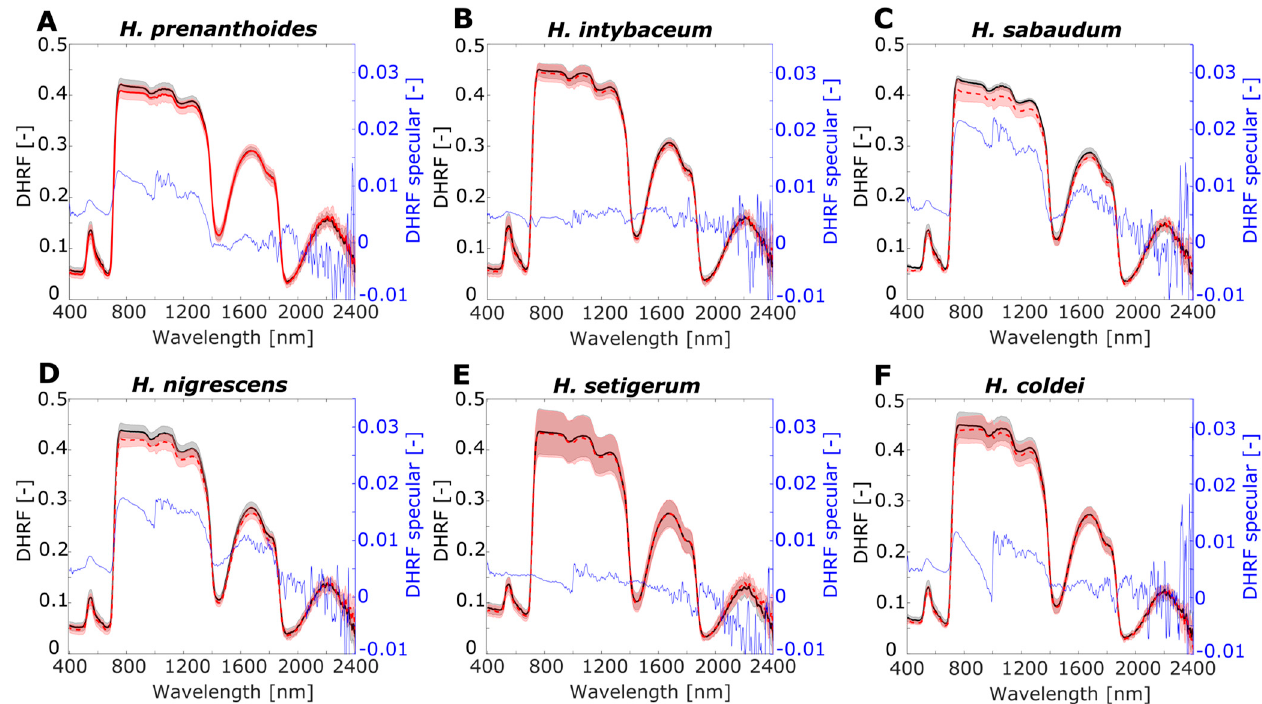
Figure 7. Leaf optical properties averaged for R TOT , R SR , and R SPEC for Hieracium species ( A ) H. prenanthoides , ( B ) H. intybaceum , ( C ) H. sabaudum , ( D ) H. nigrescens , ( E ) H. setigerum , and ( F ) H. coldei . Left y-axis shows directional–hemispherical reflectance factor (DHRF) of R TOT and R SR , and right y-axis corresponds to DHRF of specular component R SPEC . Grey and light red shadows of R TOT and for R SR curves display variance among the samples by standard deviation value. Black axes (left) correspond to DHRF of R TOT , R SR and blue axes (right) correspond to DHRF of R SPEC.